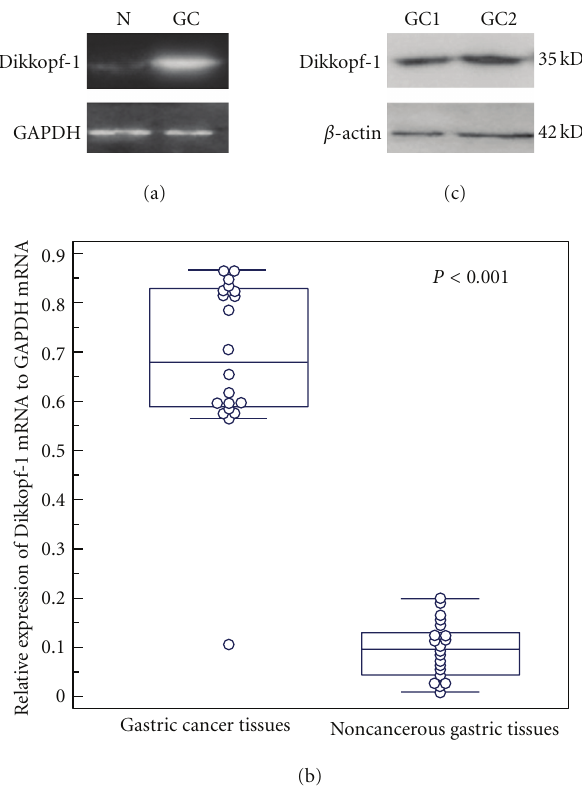
Figure 1: Real-time quantitative RT-PCR analysis of Dickkopf- 1 mRNA expression in 20 pairs of human gastric cancer and adjacent noncancerous human gastric tissues. (a) Gel images of electrophoresis. “N” refers to noncancerous gastric tissues; “GC” refers to gastric cancer tissues. (b) The average level of Dikkopf-1 mRNA expression in gastric cancer tissues was significantly higher than that in noncancerous gastric tissues ( P < 0 . 001). GAPDH gene was used as an internal control. (c) The specificity of Dikkopf-1 antibody was analyzed by western blot testing. A single band of 35kDa was detected in gastric cancer tissues. β -actin antibody was used as control with the single band of